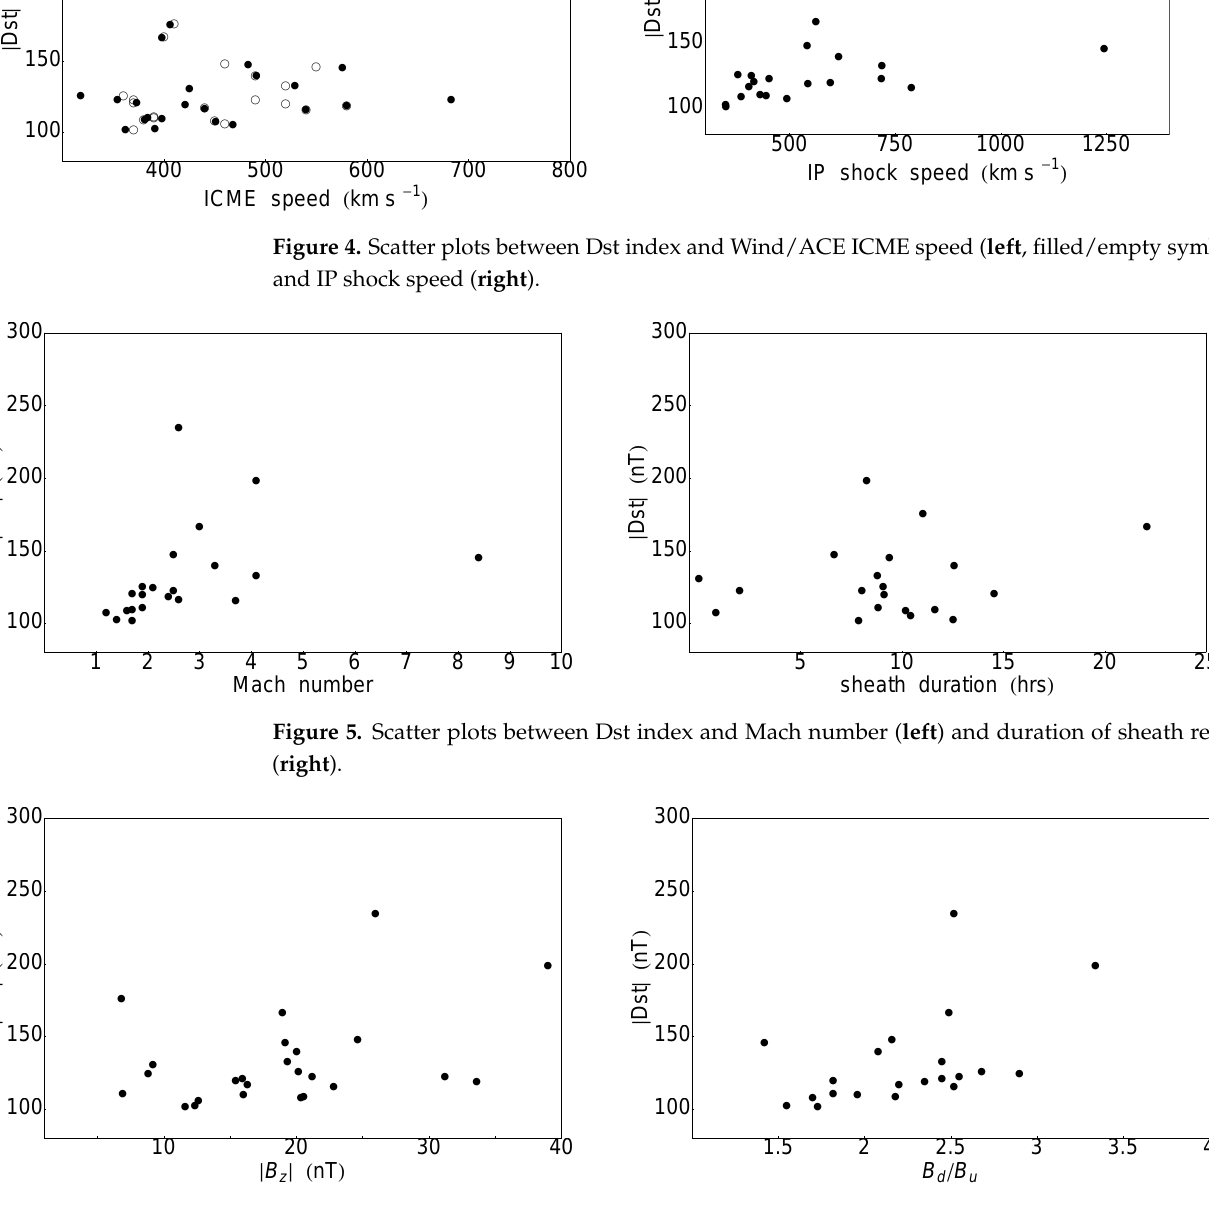
Figure 6. Scatter plots between Dst index and Bz ( left ) and magnetic field jump ( right